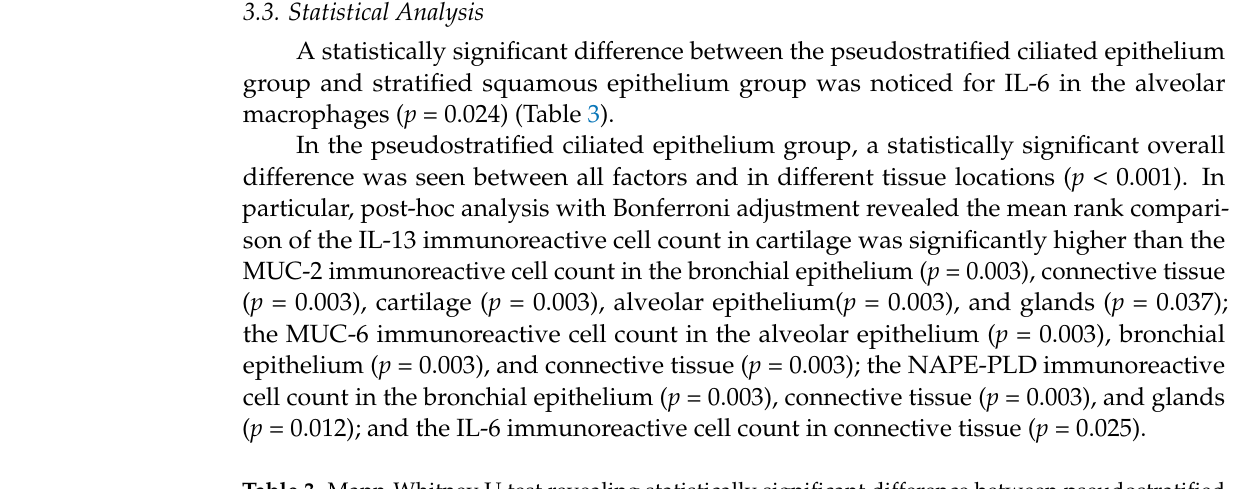
Table 3. Mann-Whitney U test revealing statistically significant difference between pseudostratified ciliated epithelium and stratified squamous